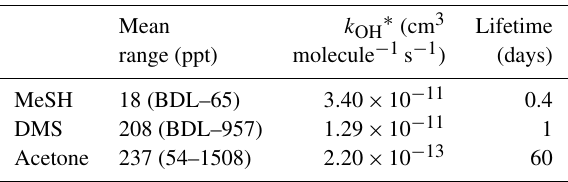
Table 2. MeSH a , DMS a and acetone a measured with PTR-MS dur- ing the SOAP voyage, with reaction rate constant for OH and cal- culated lifetime with respect to